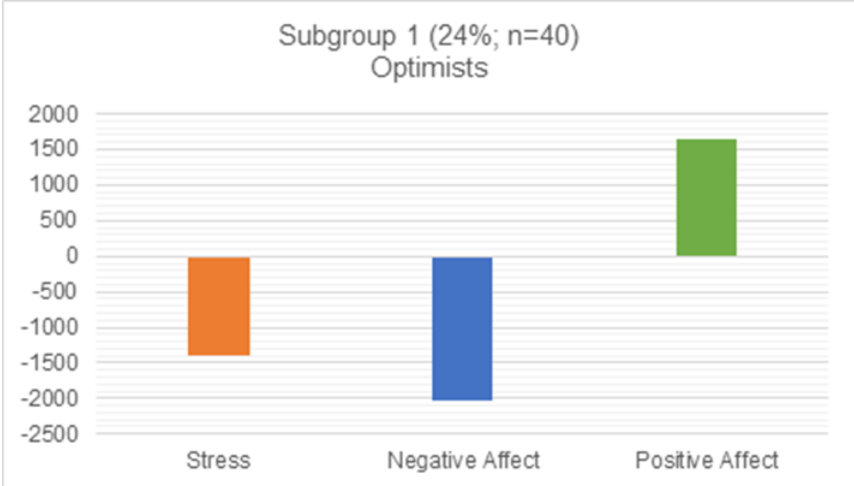
Figure 2. Class 1 relationship with stress, negative affect, and positive affect.